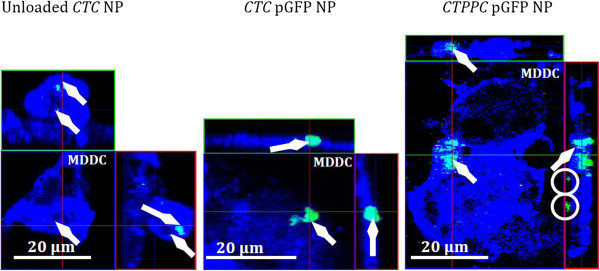
CLSM micrographs of phagocytosed NP (green) by MDDC (blue). The pictures represent single optical sections; the red line indicates the optical section of the YZ projections (right image) and the green line the XZ projections (upper image). XY and XZ-projections clearly indicate that NP are internalised by MDDC (arrow). Extracellular NP are encircled. Horizontal bar represents 20 μm.